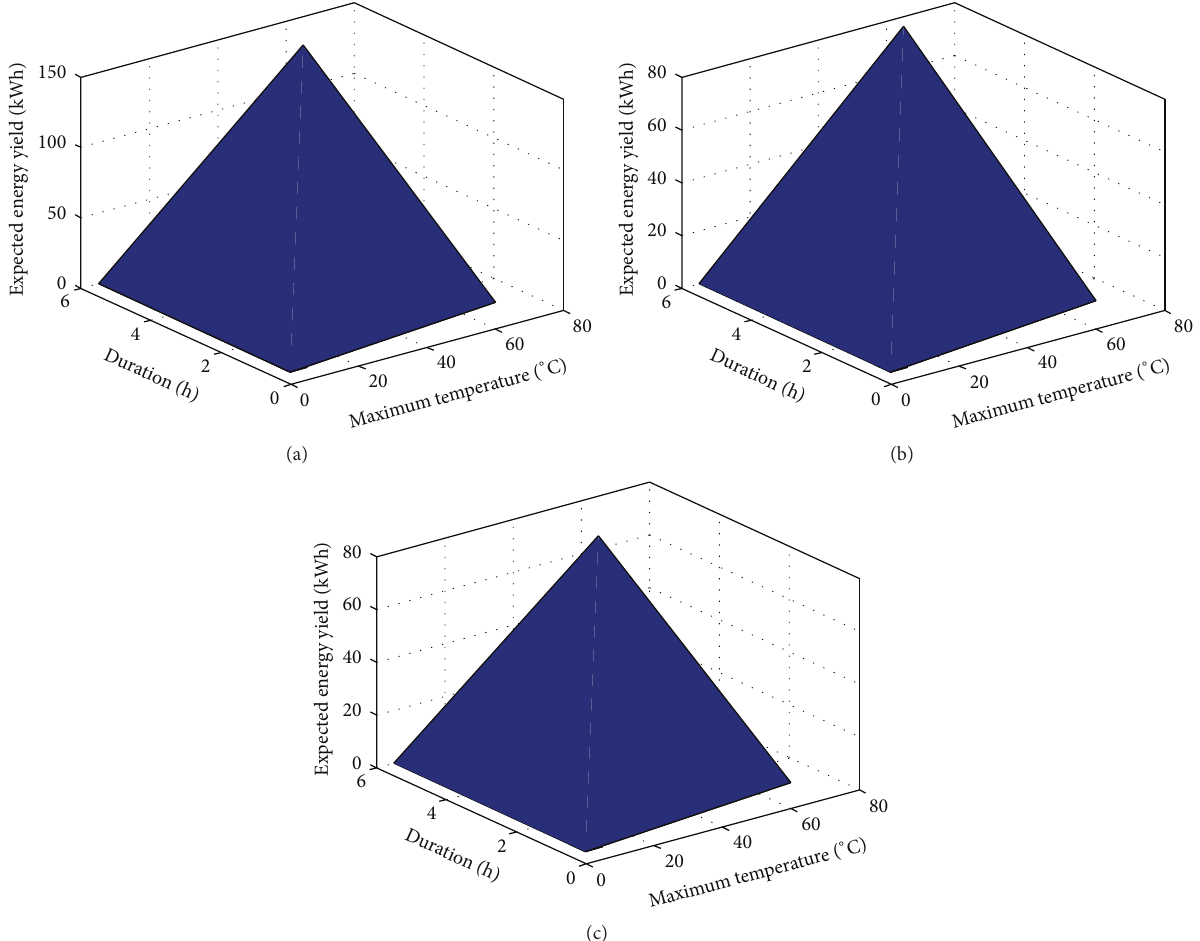
Figure 17: (a) Energy yield when PR = 0.5. (b) Energy yield when PR = 0.85. (c) Energy yield when PR =